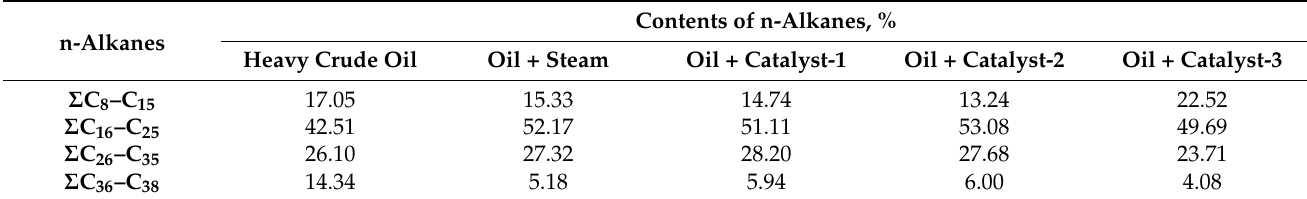
Table 6. Distribution of n-alkanes in saturate fraction of crude and upgraded oil.